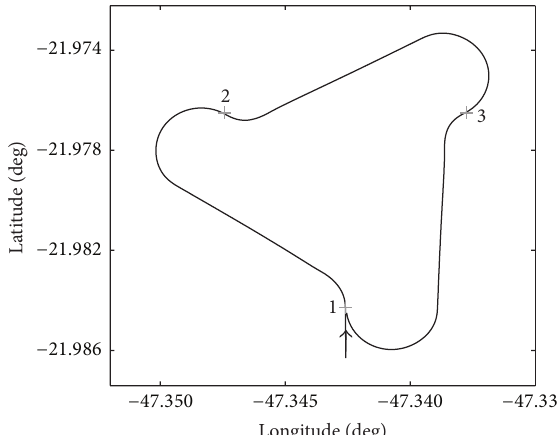
Figure 4: Horizontal path view.